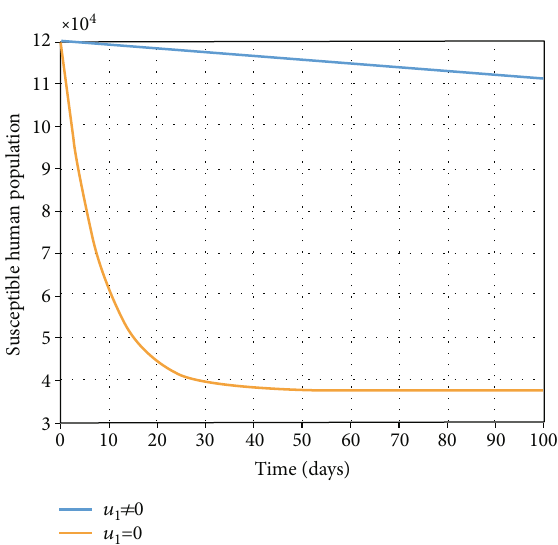
Figure 15: Infectious individuals with and without prevention strategy u 1 and intervention strategy u 2